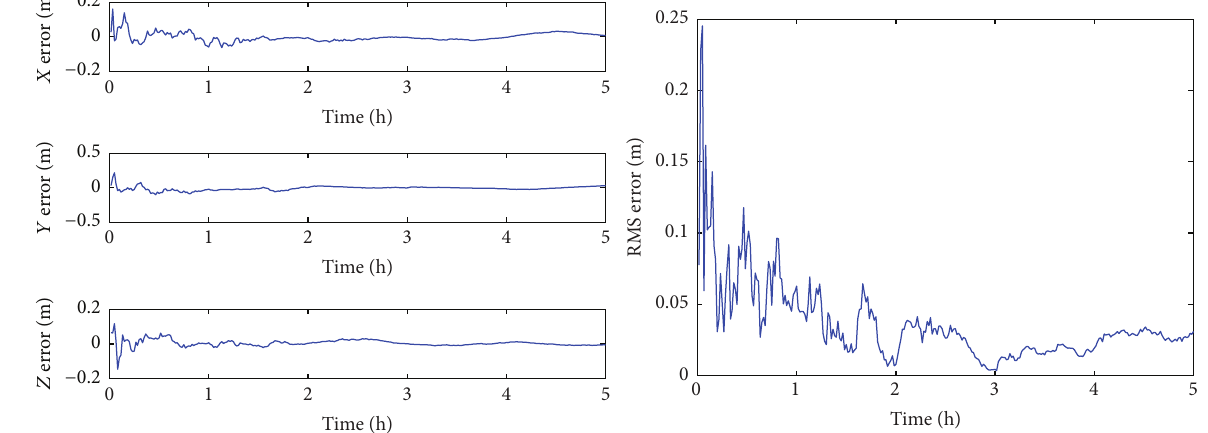
Figure 11: Error of absolute position estimation for satellite 3 using FOEKF-based ICEKF.